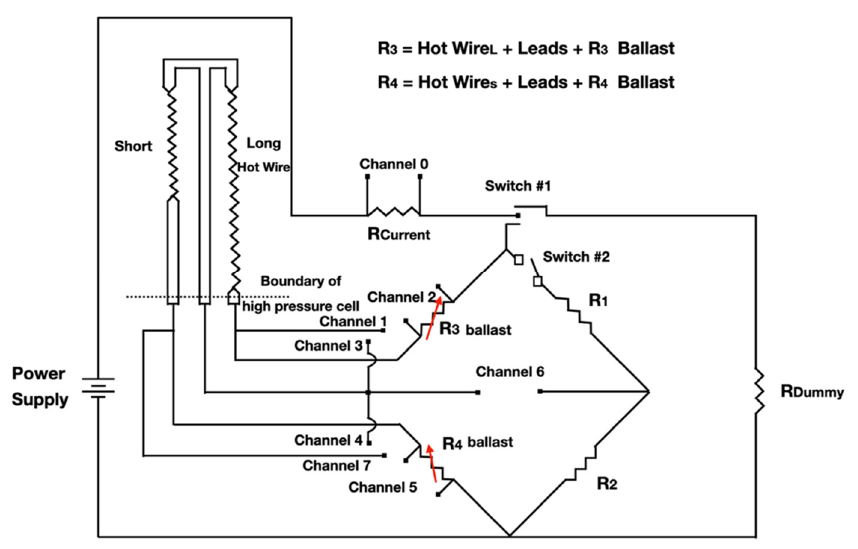
Figure 3. Schematic representation of a TWH installation with a Wheatstone bridge (adapted from Roder [35]).